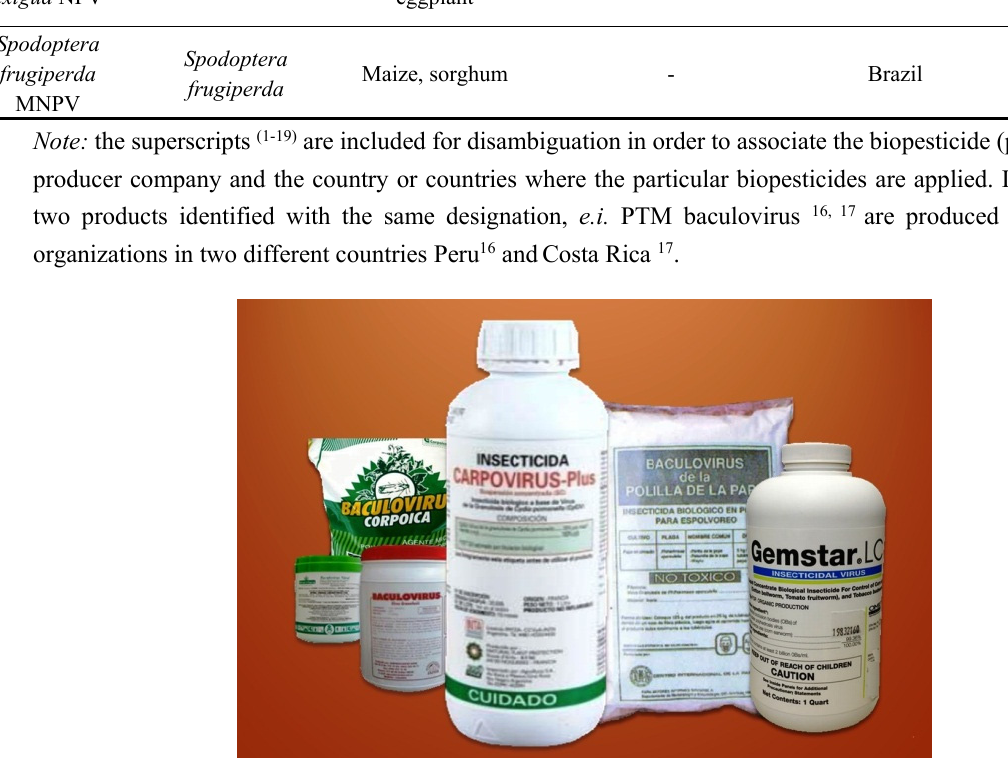
Figure 3. Some baculoviral pesticides commercialized in Latin